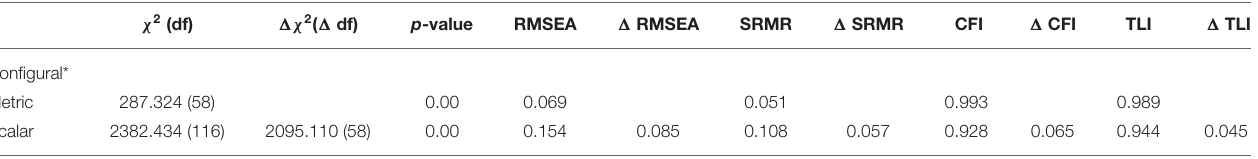
TABLE 4 | Fit statistics of the MGCFA model.